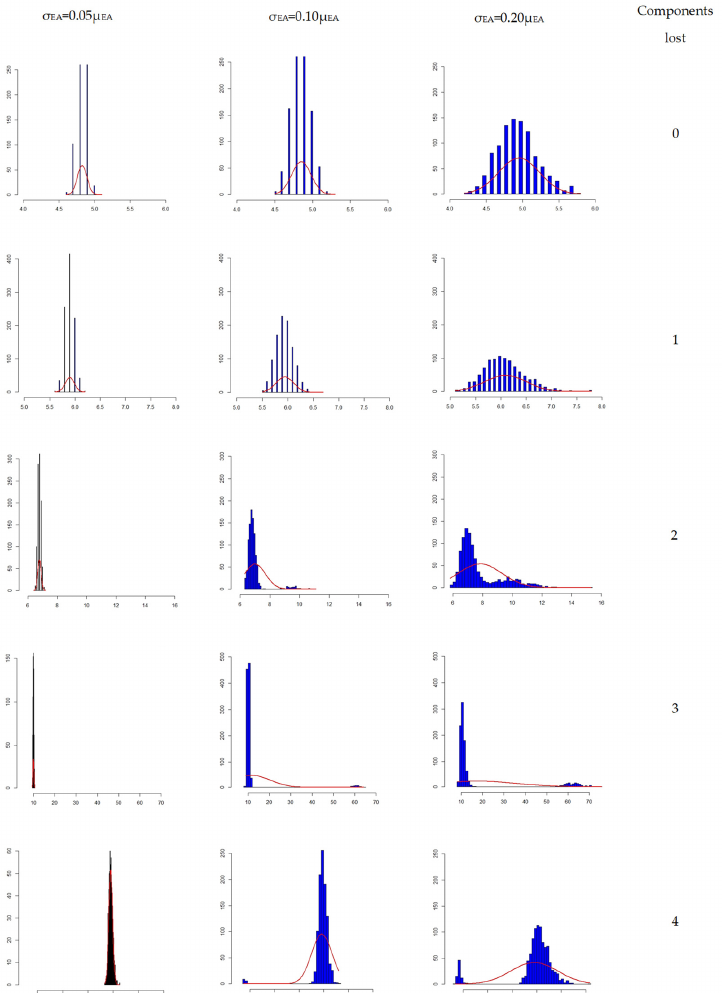
Figure 10. Distribution of system deformations of Variant 1 in the intact and different damage states, under the assumptions of variable axial stiffness (5% ( a ), 10% ( b ) and 20% ( c ) scatter of strain stiffness, for loss of 0 to 4 components); X-axes: vertical deformations ranging (mm); Y-axes: frequencies (-). However, as failed elements increase, considerable differences in the deformations can be observed, with the deviations being multiple to the expected deformation value. In the base case of deterministic elongation stiffness, a deflection of approx. 10 mm is anticipated after the failure of three components. However, a randomly distributed axial stiffness with a dispersion of 10% or 20%